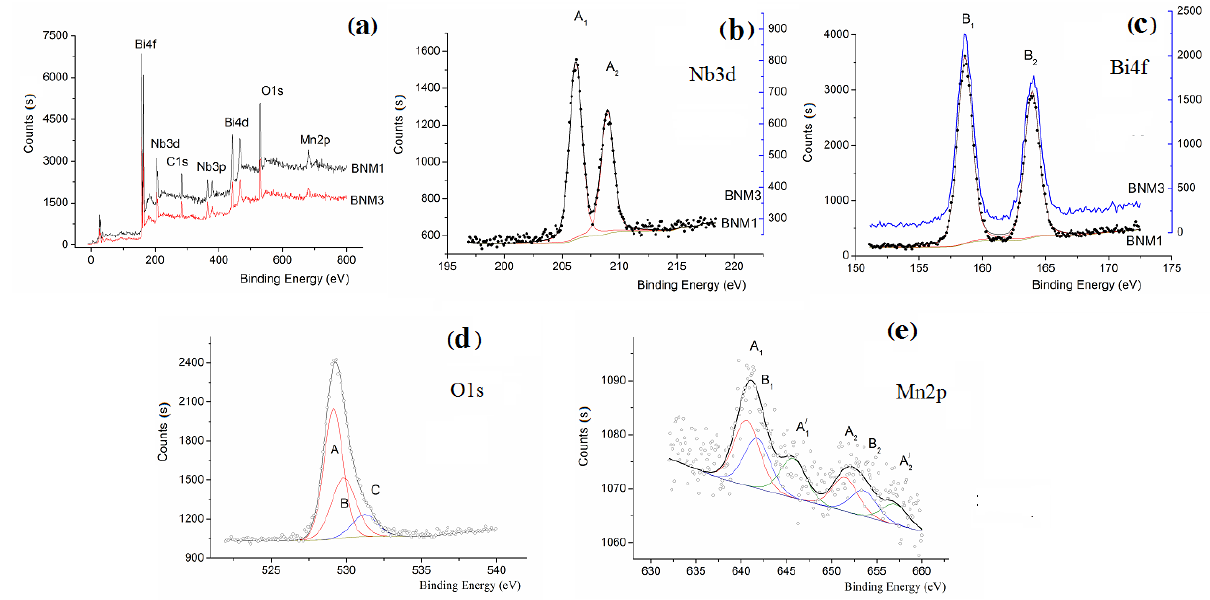
Figure 7: XPS spectra of BiNb 1− x Mn x O 4− δ (x=0.03) solid solution samples of triclinic (BNM3) and of orthorhombic (BNM1) modifications (a); XPS Nb3d spectra of the samples BNM1 and BNM3 (b); XPS Bi 4f spectra of the samples BNM1 and BNM3 (c); XPS O1s spectra (d); XPS Mn2p spectra of the samples BNM1